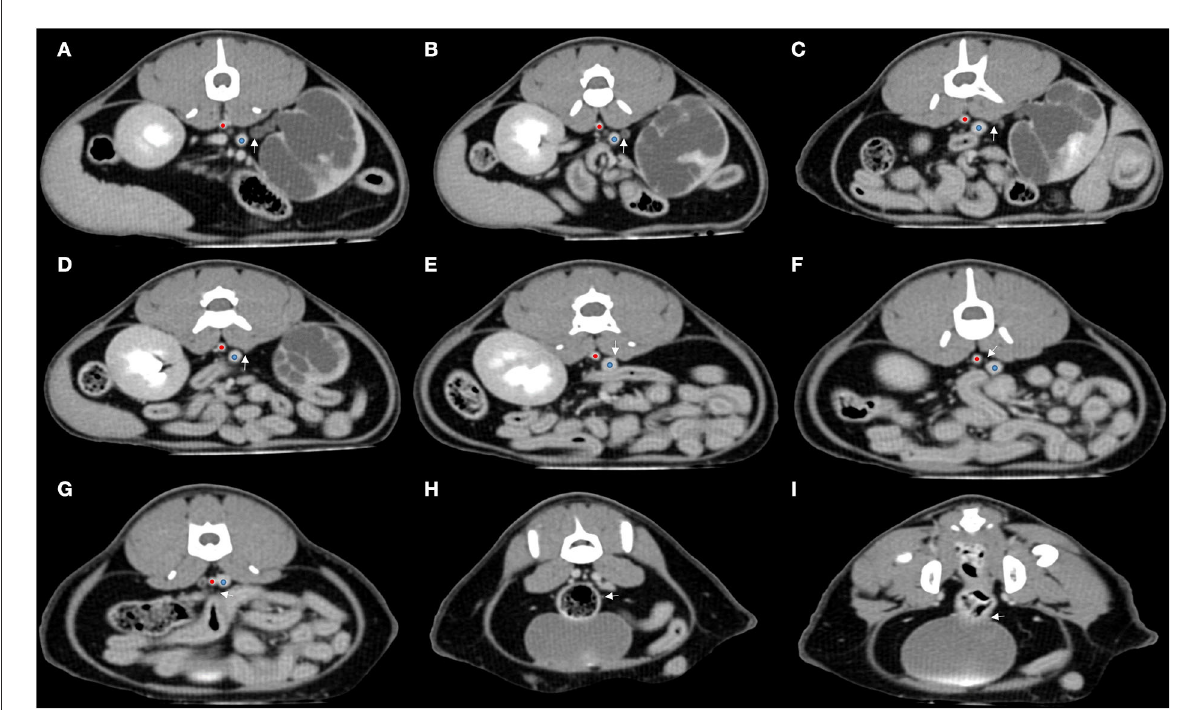
FIGURE2 Transverse MPR post-contrast reconstructions from cranial (A) to caudal (I) of the abdomen using a soft tissue algorithm at 30s after contrast. It indicated that the right circumcaval ureter ran (white arrow) dorsally to the caudal vena cava. After that, it ran medially and then ventrally toward the gap between the caudal vena cava (blue dot) and abdominal aorta (red dot).